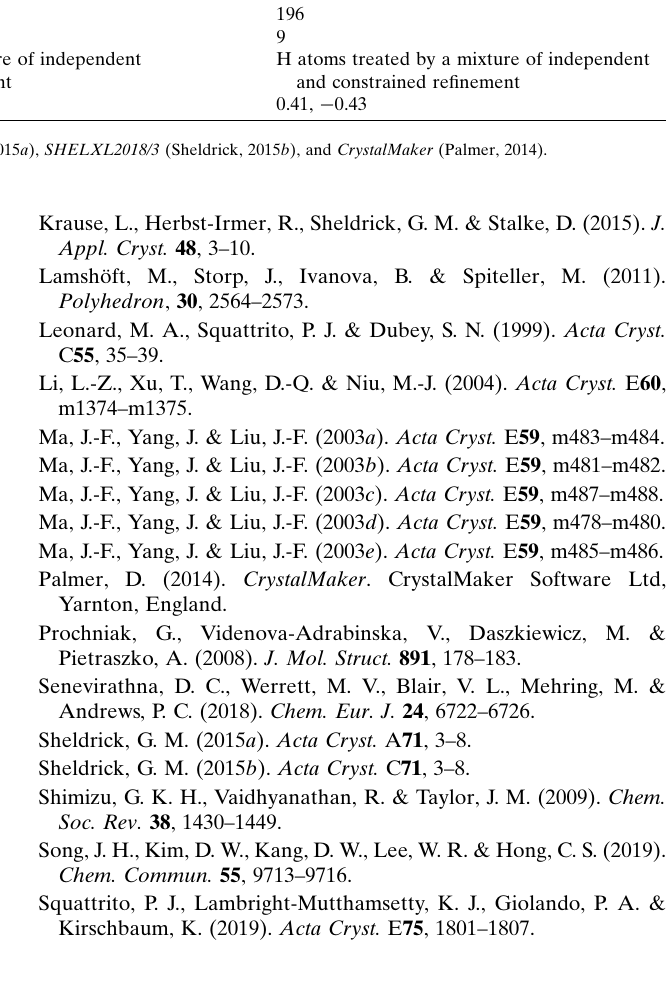
Table 3 Experimental details. Crystal data Chemical formula